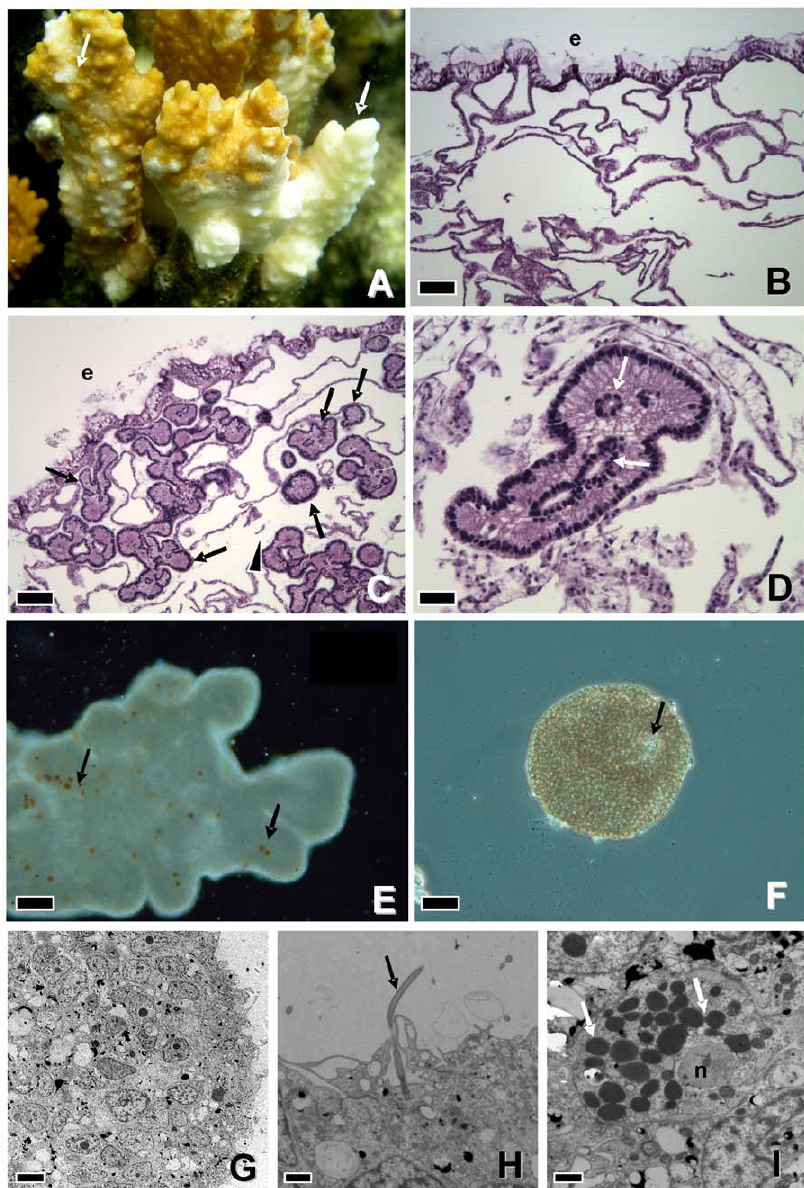
Figure 1. Montipora capitata gross lesion (A), hematoxylin and eosin (B–D), darkfield (E), phase contrast (F), and electron micrographs (G–I). A) coral manifesting gross lesions associated with IGMS; note multiple variably sized distinct amorphous area of multifocal to diffuse tissue loss revealing bare white skeleton (white arrows). B) Normal coral. Note mesenterial filaments; bar=100 m m. C) Coral with IGMS. Note numerous round to pleomorphic IGMS (arrows) within gastrovascular canals effacing basal body wall that manifests atrophy and fragmentation (arrowhead); bar=100 m m. D) Higher magnification of IGMS. Note cavities lined by cuboidal cells (arrow); bar=20 m m. E) Darkfield micrograph of amorphous IGMS. Note brown pigment granules (arrow); bar=50 m m. F) Phase contrast micrograph of round IGMS. Note what may be internal cavity (arrow); bar=50 m m. G) IGMS. Note aggregation of cells with no apparent organization, lack of gonads, nematocysts, gut, or mesoglea. Bar=10 m m. H) Rare cilia with basal body (arrow) on surface of IGMS; bar=1 m m. I) Presumed pigment cell in IGMS. Note variably-sized elliptical to